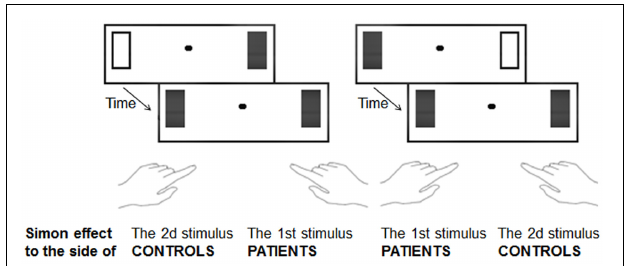
FIGURE 1 | Illustration of Simon effect used to evaluate the non-conscious processing of information in time. The two stimuli displayed on the screen were separated by a variable stimulus onset asynchrony. Subjects decided whether the two stimuli were simultaneous or asynchronous and gave their response on the left side or on the right accordingly. When asynchronies were shorter than 20 ms and simultaneity ratings were identical to those observed witth synchronous stimuli, healthy subjects nonetheless tended to press to the side of the 2nd occuring square, whereas patients tended to press to the side of the 1st